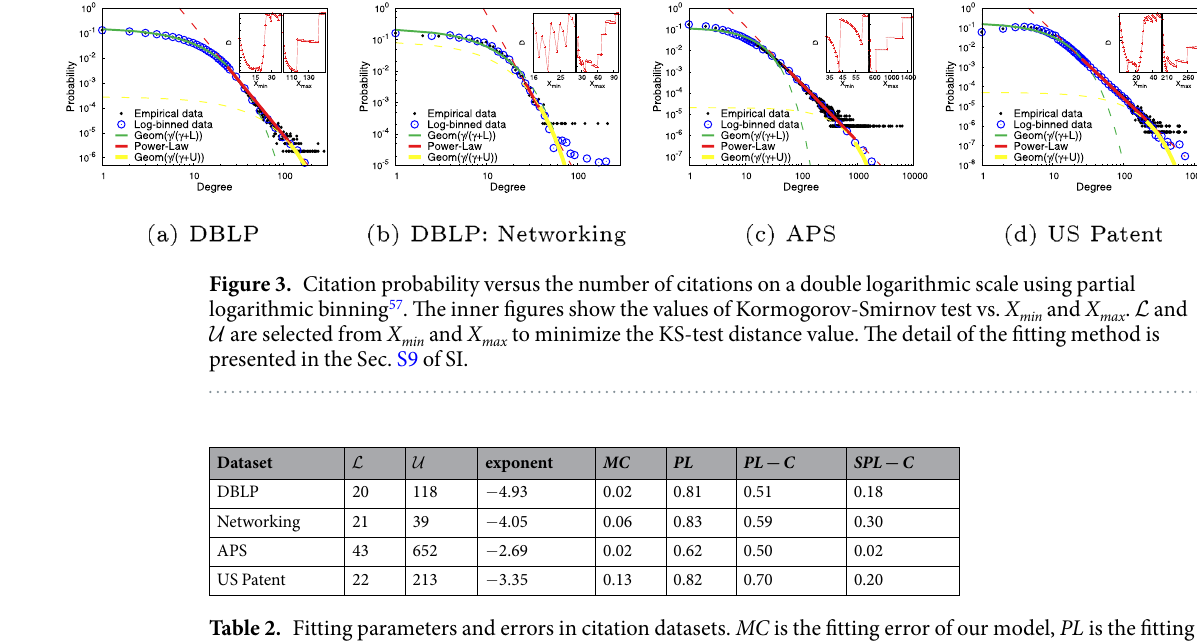
Table 2. Fitting parameters and errors in citation datasets. MC is the fitting error of our model, PL is the fitting error of using power-law, PL − C is the fitting error of using power-law with expoenetial cutoff, and SPL − C is the error of shifted power-law with geometric